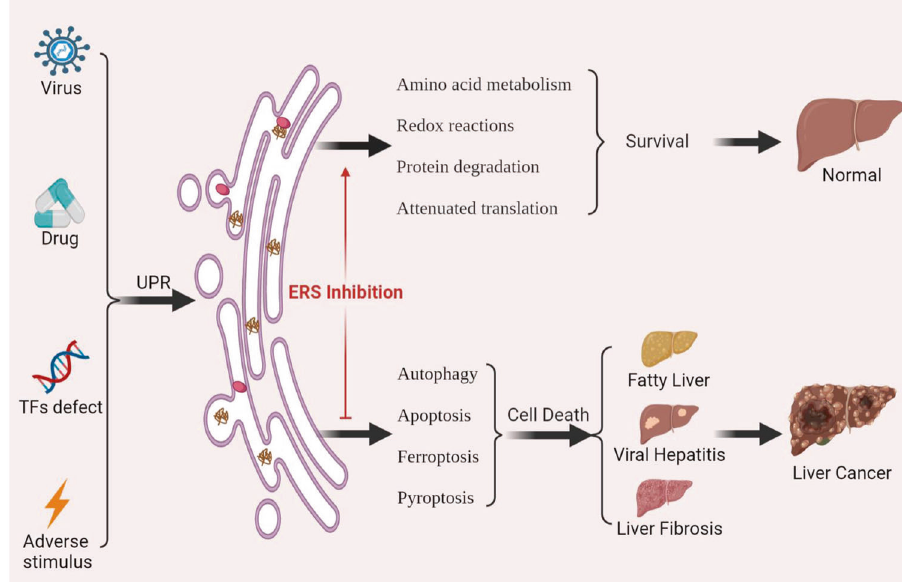
Fig. 5 Liver injury and therapeutic pathways involved in UPR. ERS and UPR are commonly induced in the liver in response to stimuli such as viruses, drugs, and high-fat diet (HFD). When stimulation is weak, it can be adaptively regulated by amino acid metabolism, redox reaction, protein degradation, and attenuated translation to maintain the normal physiological function of the liver. When the stimulation is enhanced or prolonged, it will cause cell death and lead to viral hepatitis, fatty liver injury, drug-induced liver injury (DILI), and even hepatocellular carcinoma (HCC). Therefore, ERS can also regulate cell death in the process of liver injury to achieve the therapeutic effect of liver